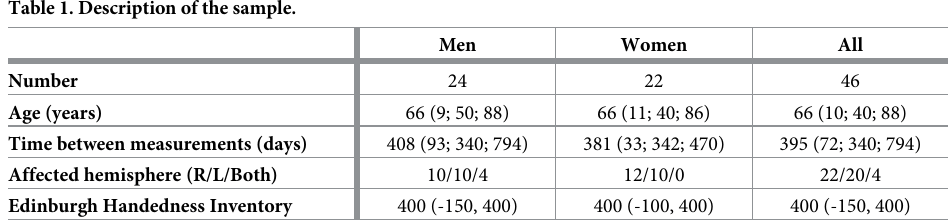
Table 1. Description of the sample.